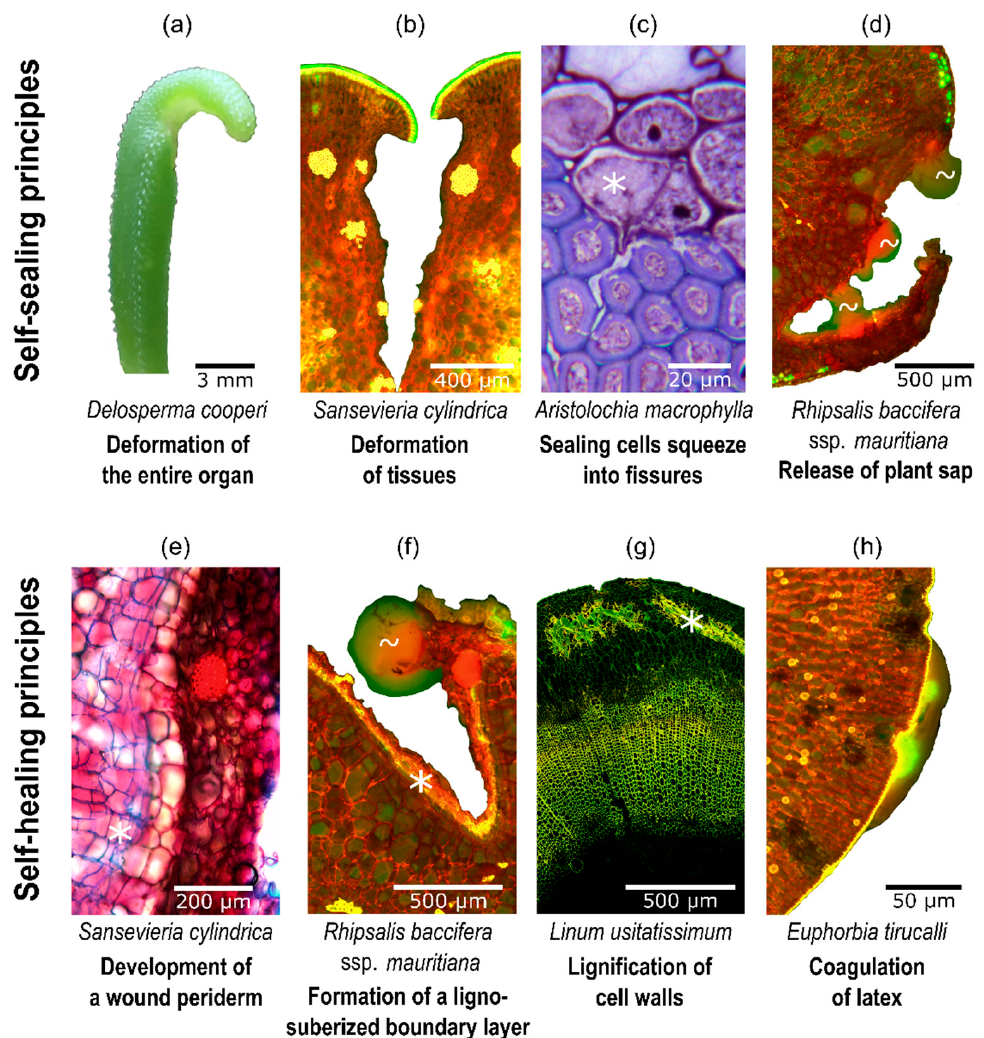
Figure 2. Examples of plant species showing various types of wound reactions. ( a ) The bending of the entire leaf sealing the wound within approximately 60 min after the damage and subsequent wound healing over a longer time period (days or weeks). ( b ) The rolling-in of the dermal tissues at the wound edges (epidermis with cuticle) reduces the size of the wound opening. ( c ) Thin-walled parenchyma cells (*) deform and squeeze into the (micro)fissures of the thick-walled and lignified sclerenchyma cells. ( d ) Injuries are immediately sealed by mucilage (~) released from destroyed mucilage cells in the wound region. ( e ) Development of a wound periderm including cell division (*). ( f ) Formation of a ligno-suberized boundary layer around the wound (*), mucilage discharge (~) covering the wound surfaces having taken place in the sealing phase. ( g ) Lignification of formerly nonlignified cell walls of bast fibers (*) in the wound area. ( h ) Release of latex immediately after the injury, which forms a permanent plug of coagulated latex within minutes. ( b , d , f , g , h ) Thin sections stained with acridine orange, which highlights lignified structures in bright yellow-green; ( c ) cross-section stained with toluidine blue, which highlights lignified structures in blue; ( e ) thin-section stained with fuchsin-chrysoidine-astra blue according to Etzold after which lignified cell walls appear bright red and nonlignified cell walls are highlighted in